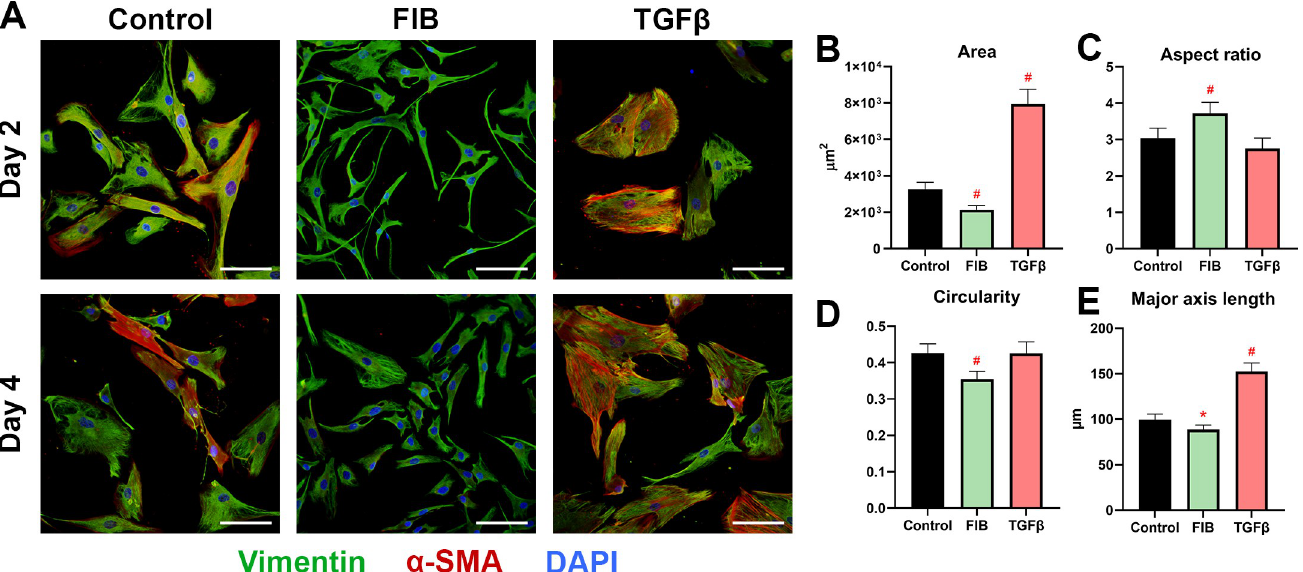
Fig 3. FGF-2 and TGF- β differentially influence cell morphology. (A) depicts representative images of hVICs on day 2 and 4, immunostained for α -SMA (red), vimentin (green), and DAPI (blue). Scale bars represent 100 μ m. The following morphological characteristics are derived from pooling days 2 and 4, as the 2-way ANOVA showed that the ‘time’ factor did not significantly affect any parameter. Comparisons are ordinary one-way ANOVAs between control and the experimental groups. For image analysis, 6 biological replicates were used (n = 6); 6 representative images were taken from each biological replicate per treatment per timepoint, representing > 75 cells per experimental group. These are: (B) cell area in μ m 2 , (C) aspect ratio, the long axis divided by the short axis of each cell, (D) the ‘circularity’ of each cell. This measure is defined by 4 π (area/perimeter 2 ), and E) the length of the major axis. � p < 0.05, #p < 0.01, error bars represent 95% CI.